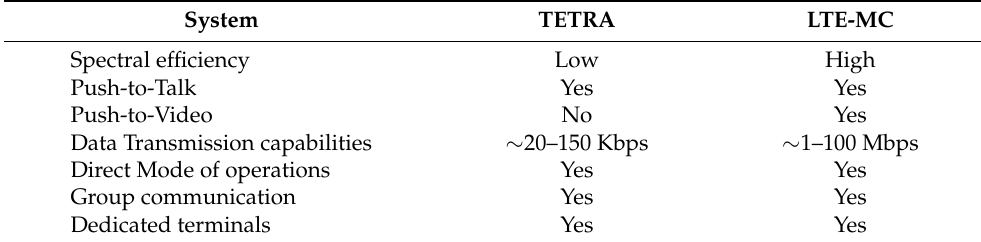
Table 1. Comparison of TETRA and